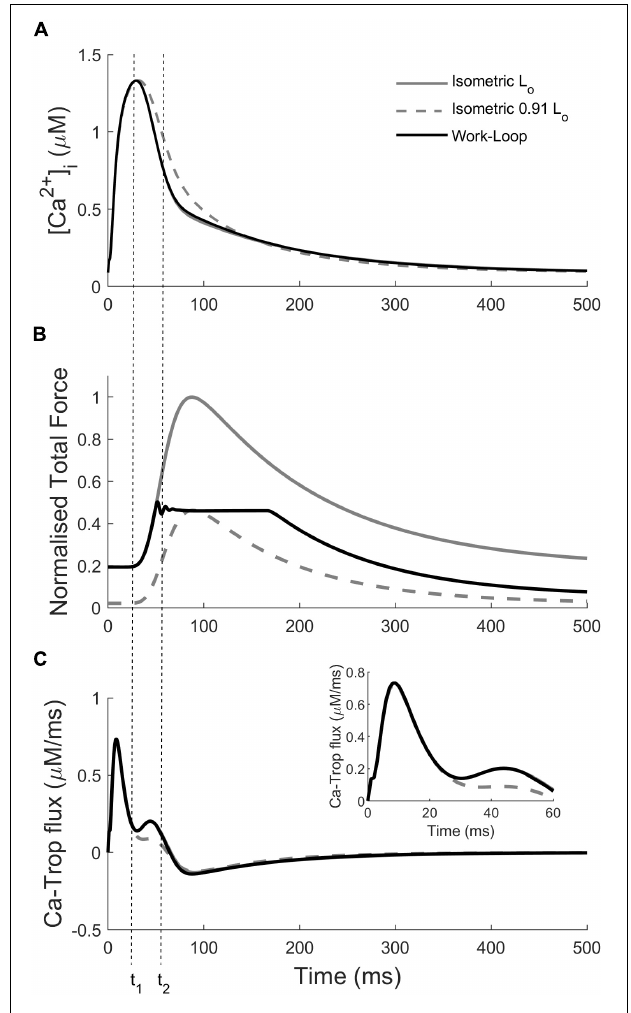
FIGURE 5 | Simulations highlighting the mechano-calcium feedback mechanism. Simulated intracellular Ca 2 + transient (A) , total force production (B) , and Ca-troponin flux (C) for an L o -isometric contraction, and a pair of isometric (SL = 0.91 L o ) and work-loop (normalized afterload at 0.45) contractions at the same peak force. Inset: close-up of the Ca-troponin flux at the start of the twitch. The dotted vertical lines indicate the times at the start of force production (t 1 ) and at the start of the isotonic phase in the work-loop contraction (t 2 ).